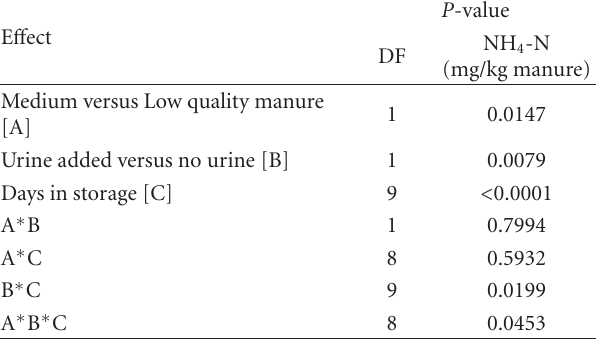
Table 2: ANOVA results for NH 4 -N concentration (mg NH 4 - N/kg manure, DM basis) of manure in storage in the dry season experiment. Fixed e ff ects are the manure quality (Medium versus Low quality), the presence or absence of urine in the manure, and the number of days the manure was incubated (0, 6, 12, 18, 24, 30, 50, 70, 90, or 120 days). Terms for the interaction between fixed e ff ects are denoted by fixed e ff ects terms separated by an asterisk ( ∗ ). DF represents the degrees of freedom of the test.